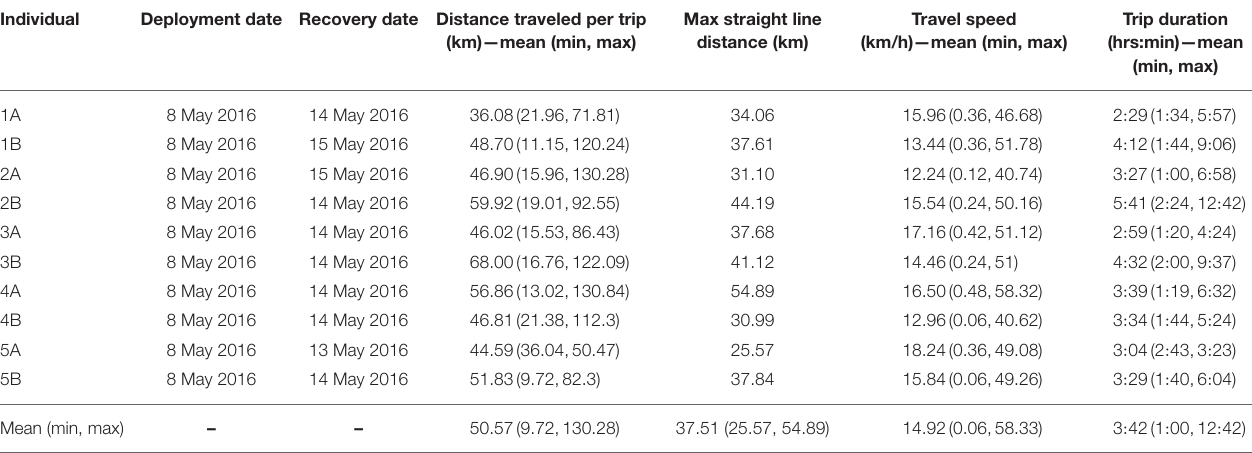
TABLE 1 | Deployment and movement summary.